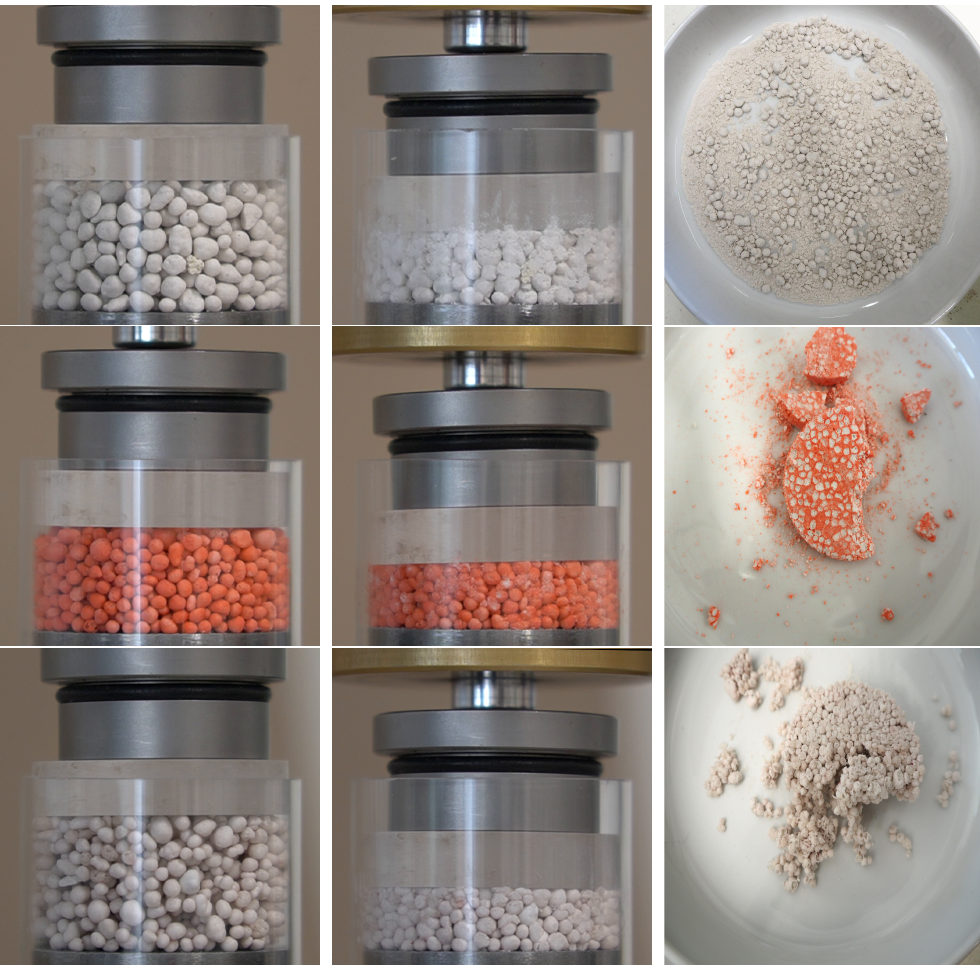
Figure 9. Three stages of multi-particle compression: at the start ( left ), during punch motion with velocity 1 mm/min ( center ), and at the end, when crushed particles were removed from the cylinder ( right ) for uncoated ( top ), Candelilla wax-coated ( middle ) and silicone-coated ( bottom ) Poraver ®